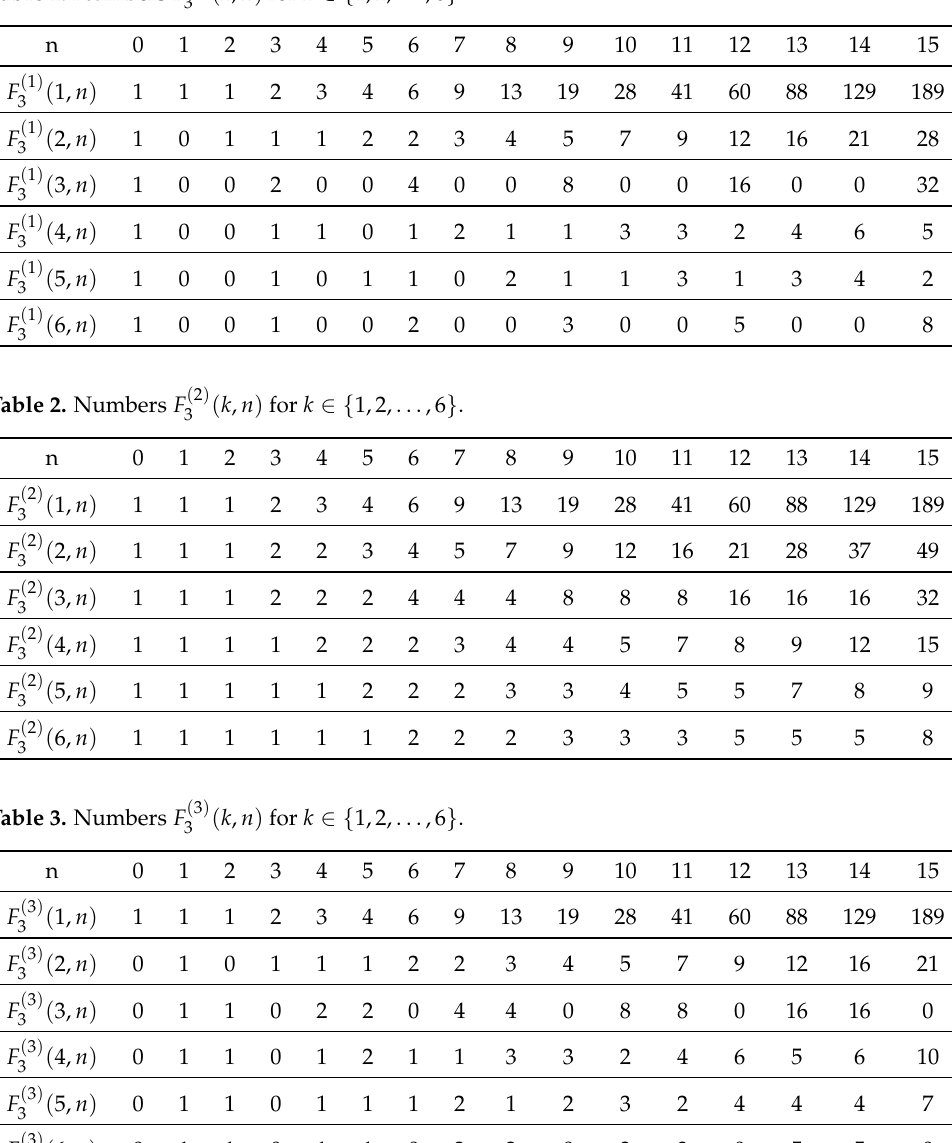
Table 1. Numbers F